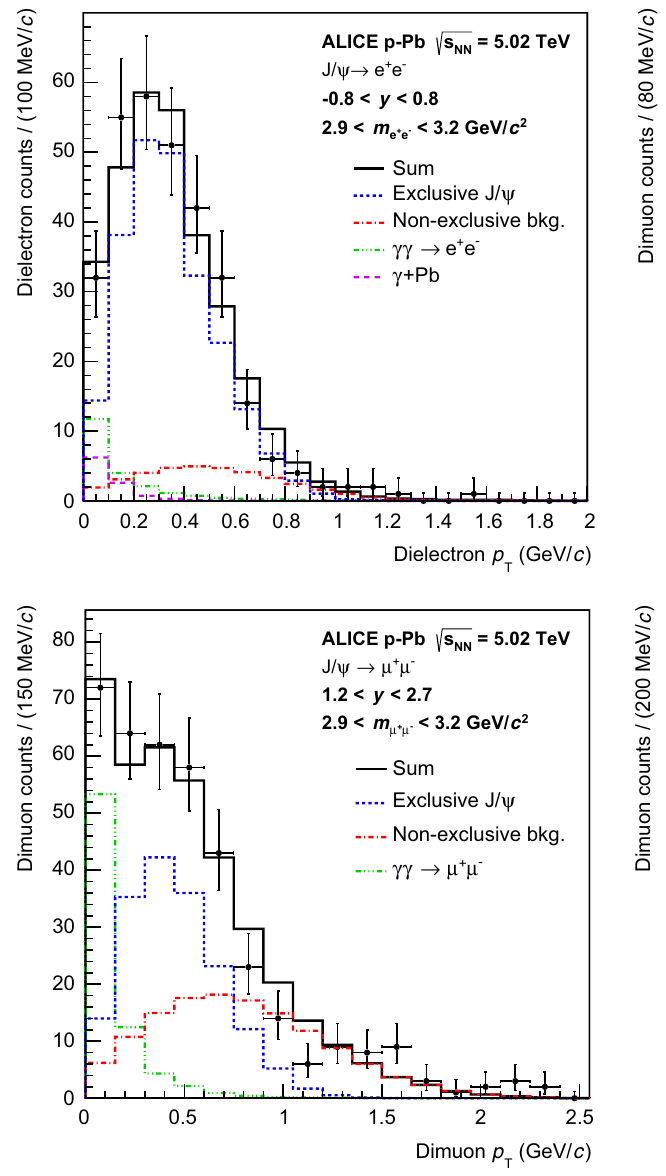
Fig. 2 Transverse momentum distributions of dileptons around the J /ψ mass for the dielectron (upper left) and dimuon (upper right) sam- ples for the central analysis and dimuon samples for the semi-forward (lower left) and semi-backward (lower right) analyses. In all cases the data are represented by points with error bars. The blue, magenta (dash)